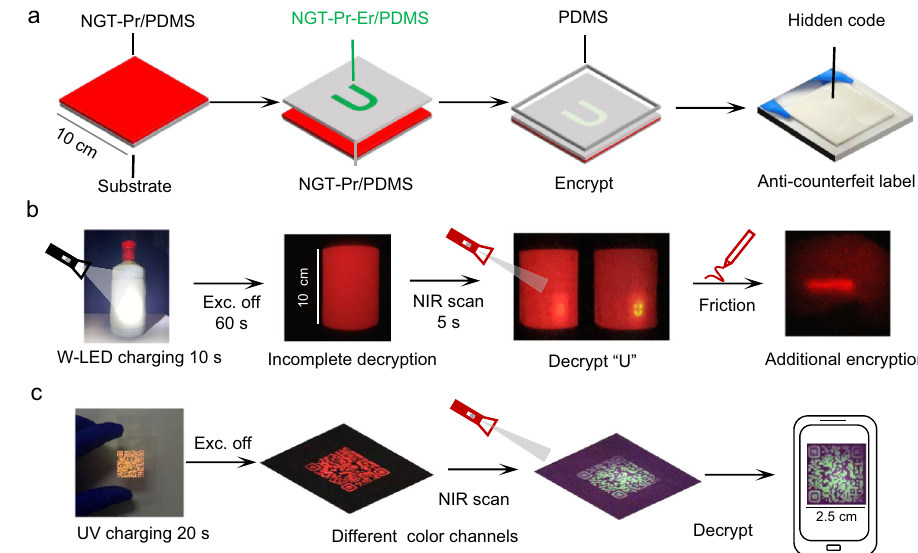
Fig. 4 | Multilevel anti-counterfeiting application based on real time color- conversioninPr 3+ ,Er 3+ -dopedNGT.a Generaldesignofthehiddentwo-dimension patterns made with NGT:Pr 3+ , Er 3+ of different composition. Thepattern consists of three layers, which deposited in turn on a glass substrate (10×10cm). The as- prepared multimode luminescent particles and PDMS were mixed and used for different functions: (from left to right) NGT:0.1%Pr 3+ @PDMS as background